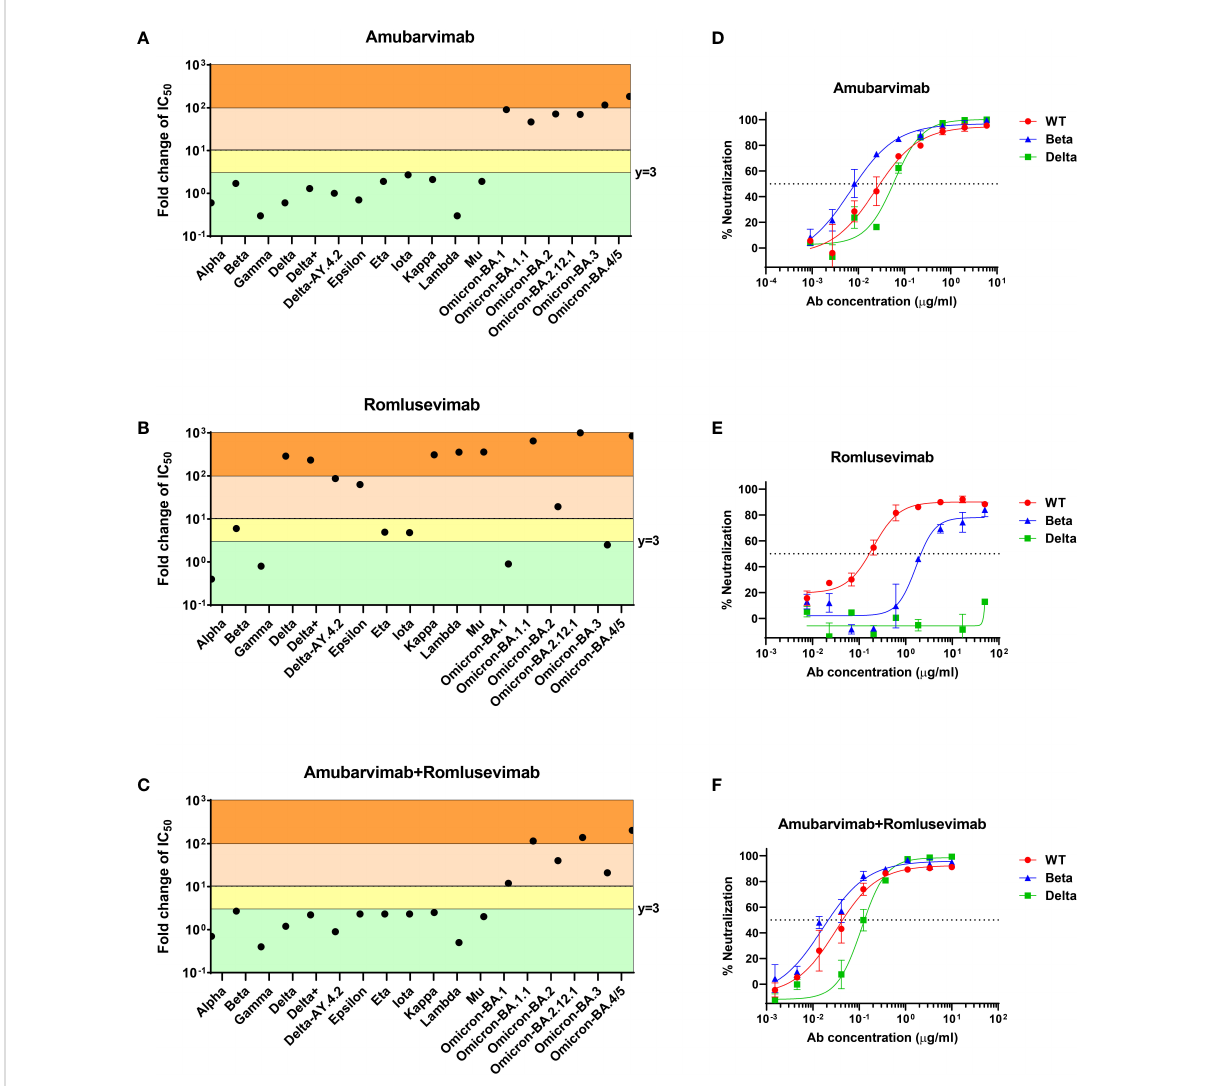
FIGURE 3 Amubarvimab, romlusevimab and amubarvimab+romlusevimab neutralize SARS-CoV-2 VOCs/VOIs in vitro . (A – C) Neutralization potency of amubarvimab, romlusevimab, and their 1:1 combination against SARS-CoV-2 VOCs/VOIs. Data shown represents fold-change in neutralization potencies (IC 50 ) of amubarvimab (A) , romlusevimab (B) and amubarvimab+romlusevimab (C) against the past and present circulating VOCs/VOIs compared with the D614G wild-type pseudotyped VLPs. (D – F) In vitro neutralization of wild-type, Beta and Delta authentic live virus with amubarvimab (D) , romlusevimab (E) , and amubarvimab and romlusevimab together (F) . Results are representative of at least two independent